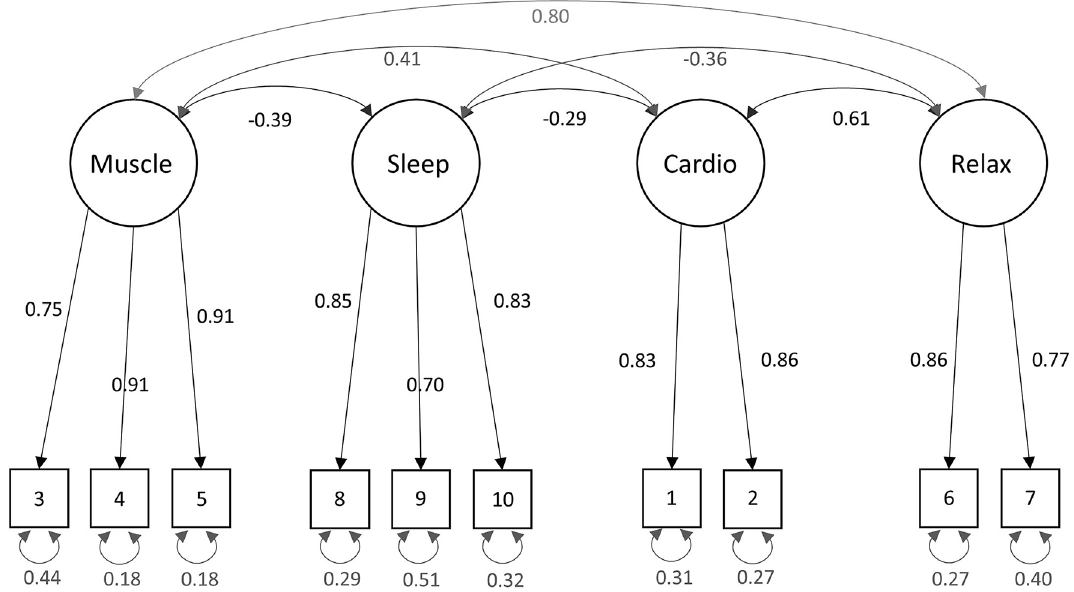
Figure 1. Structure model with parameter estimates. Note. Items are numbered as indicated in Table 2. All parameter estimates are standardized.